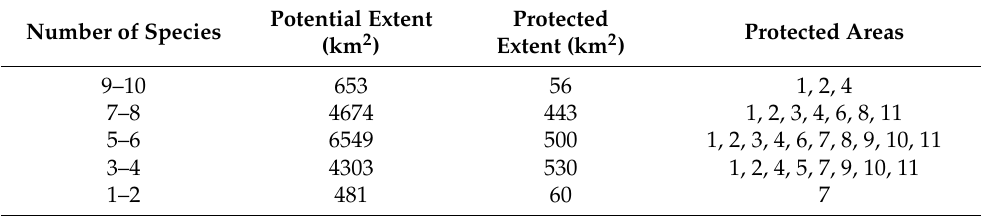
Table 5. Potential extent and surface covered by protected areas according to the number of threat- ened pollinator species that overlapped suitable areas for avocado cultivation in Mexico.